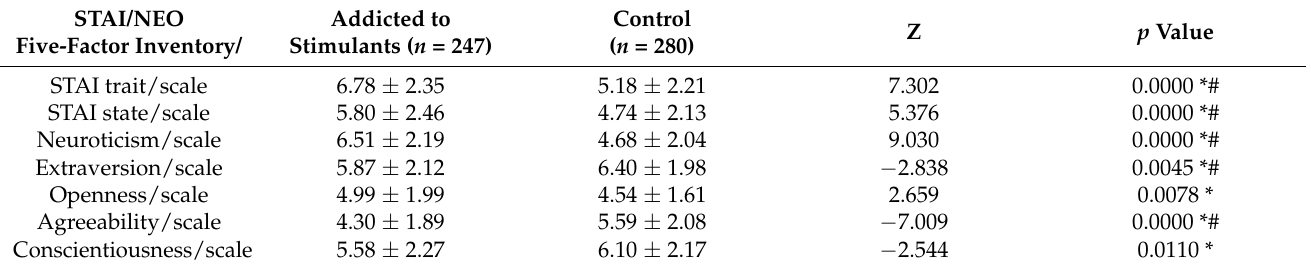
Table 4. STAI, NEO Five-Factor Inventory results (sten scale) between healthy controls and patients diagnosed with other stimulants